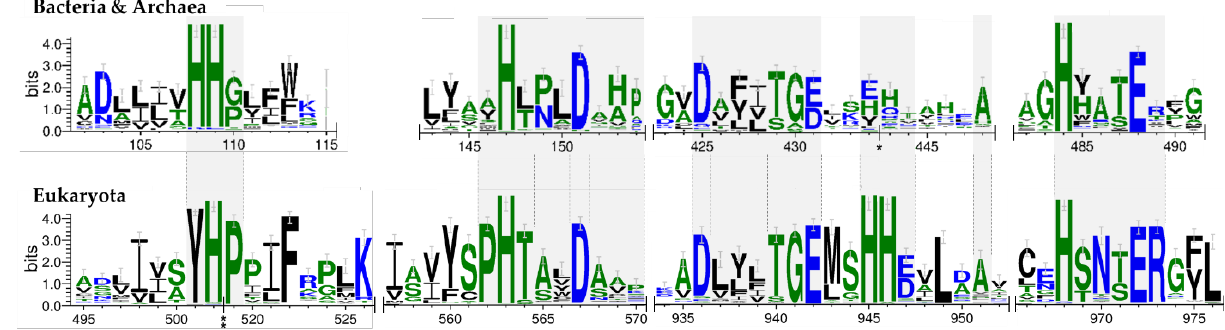
Figure 2. Key motifs of Bacteria and Archaea compared to those of Eukaryota. Sequences were aligned for eukaryotic sequences, separately, and, for bacterial and archaeal sequences, combined. A multiple motif method was used to determine and compare family signatures. A full figure illustrating the distinct levels of conservation per superkingdom can be examined in Figure S3.